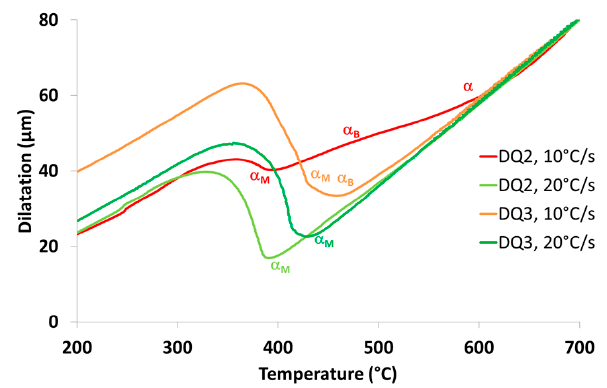
Figure 4. Dilatometry curves for DQ2 and DQ3 steels, cooling rates of 10 and 20 °C/s. (Thermal cycles: heating to 850 °C with 10 °C/s, holding time 300 s before final cooling).